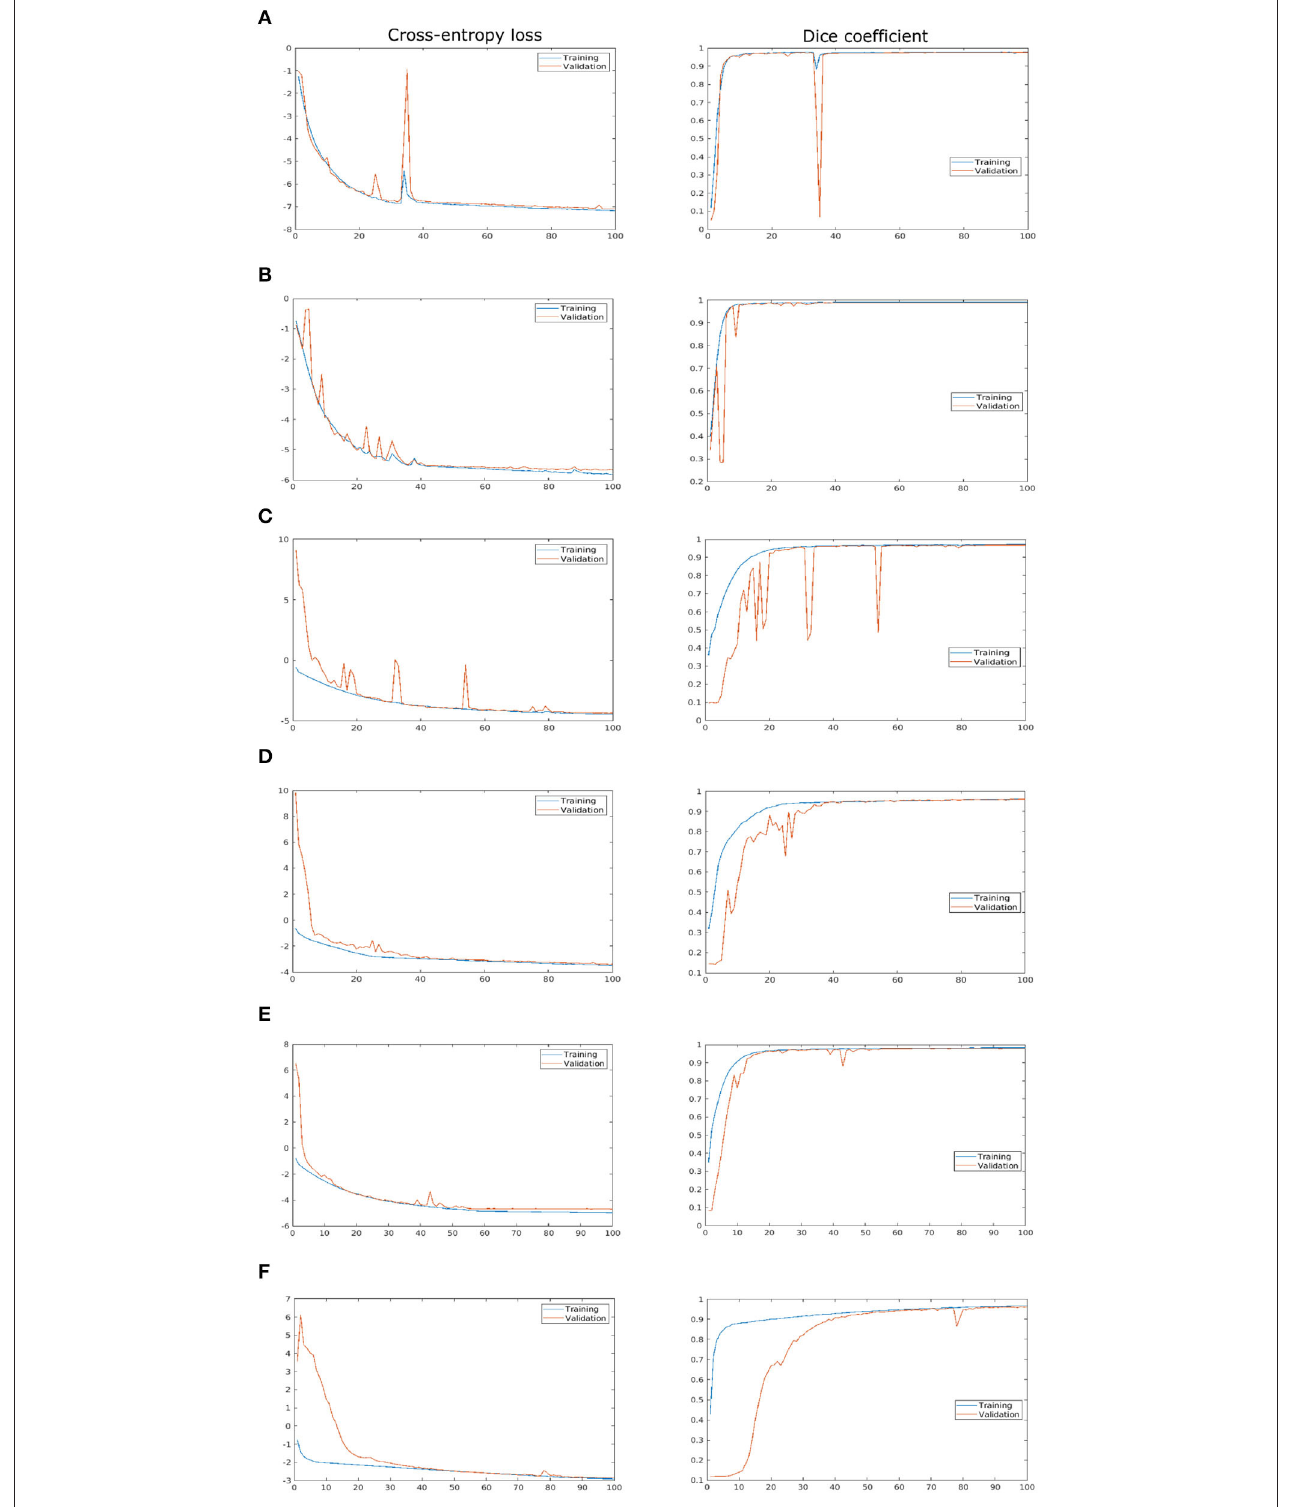
FIGURE 4 | Training and validation performance of the shoot model over 100 epochs. X- and Y-axes represent the epoch number and performance measure, respectively. For visualization purposes, logarithmic cross-entropy values are plotted for all models. (A) Arabidopsis side view, (B) Arabidopsis top view, (C) Barley side view, (D) Barley top view, (E) Maize side view, and (F) Maize top view.